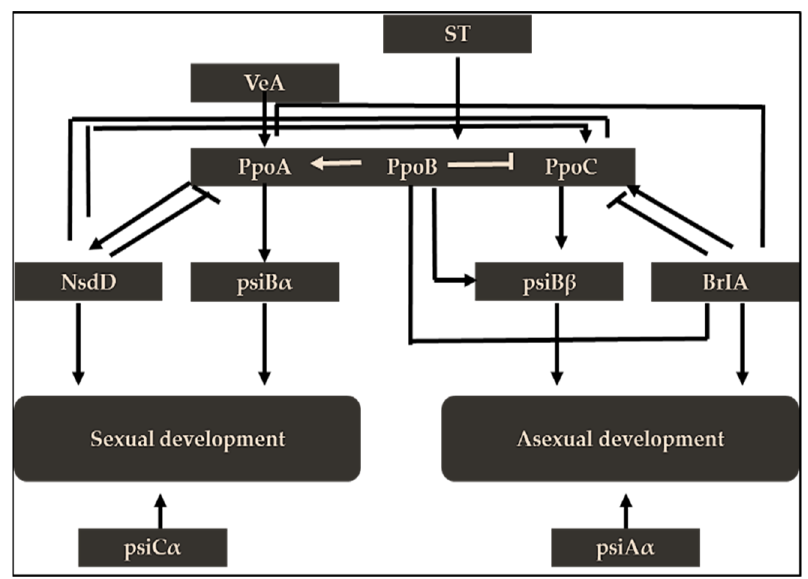
Figure 6. Ppo effects on ST production (source: the author).